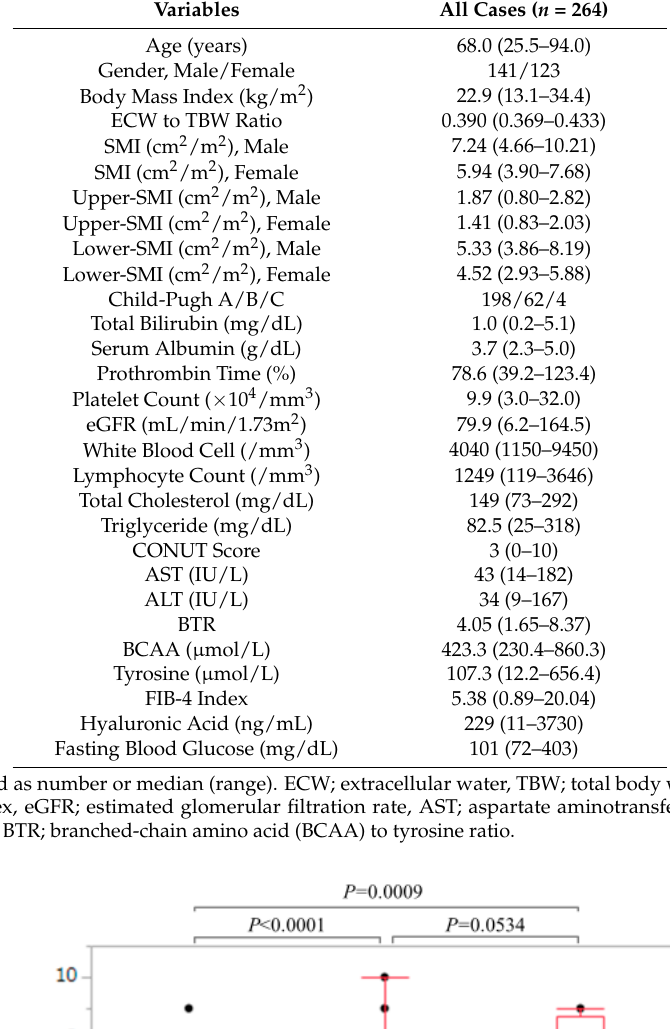
Table 2. Baseline data ( n = 264).